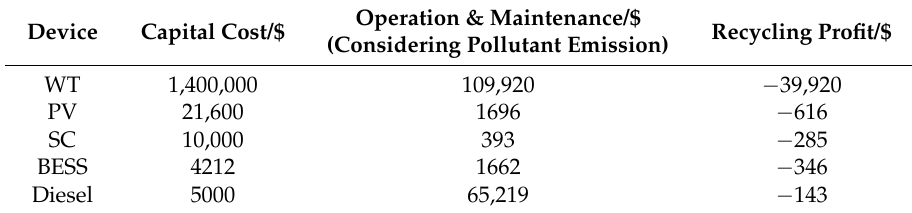
Table 9. Life cycle costs (LCC) of each device.